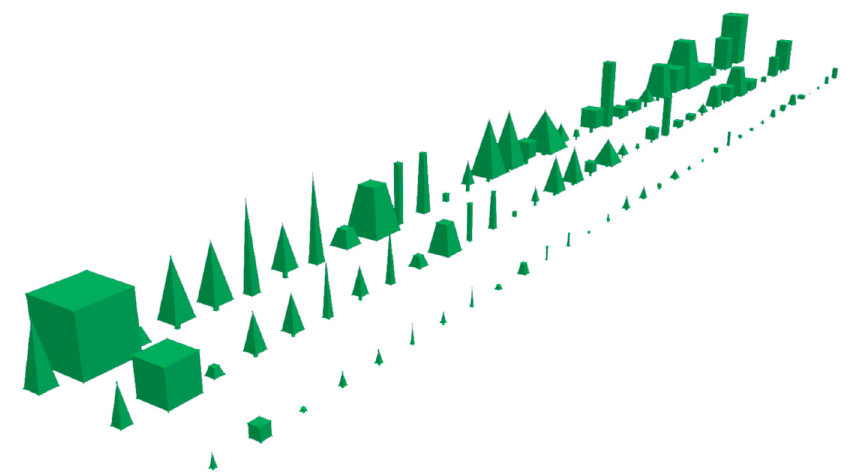
Figure 2. Trees and large shrubs created in the DepthSpace 3D software, according to the attributes shown in Table 1.